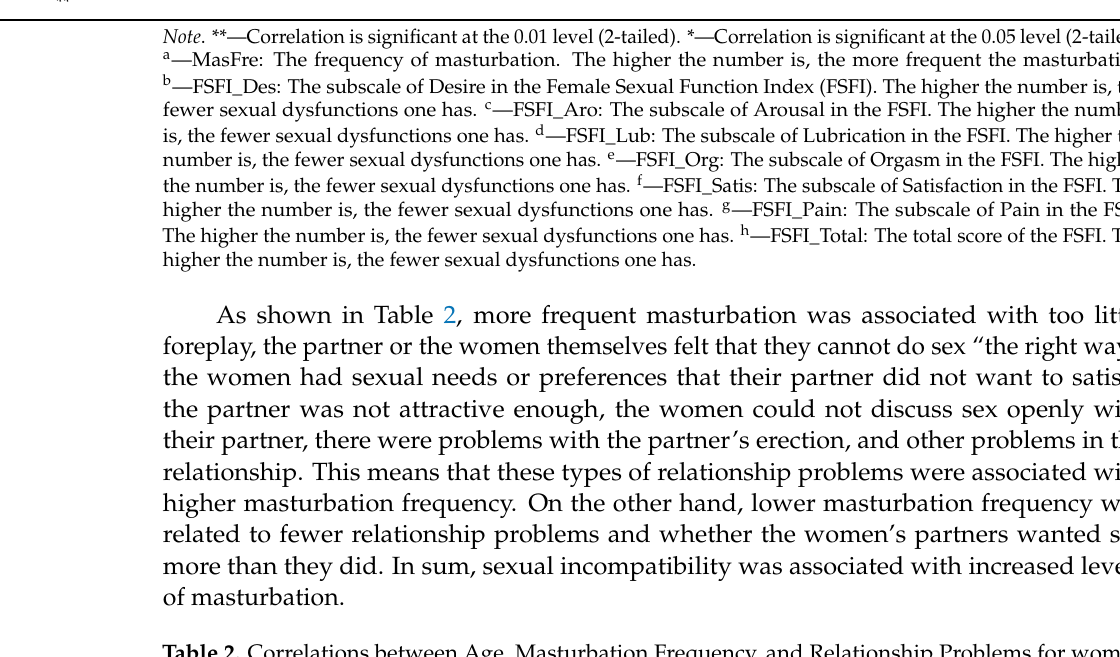
Table 2. Correlations between Age, Masturbation Frequency, and Relationship Problems for women who have a